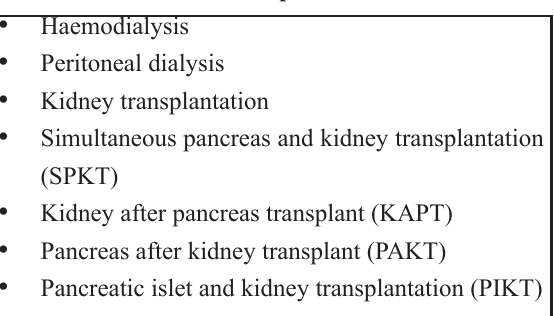
Table I : Choices of therapies for ESRD and DM